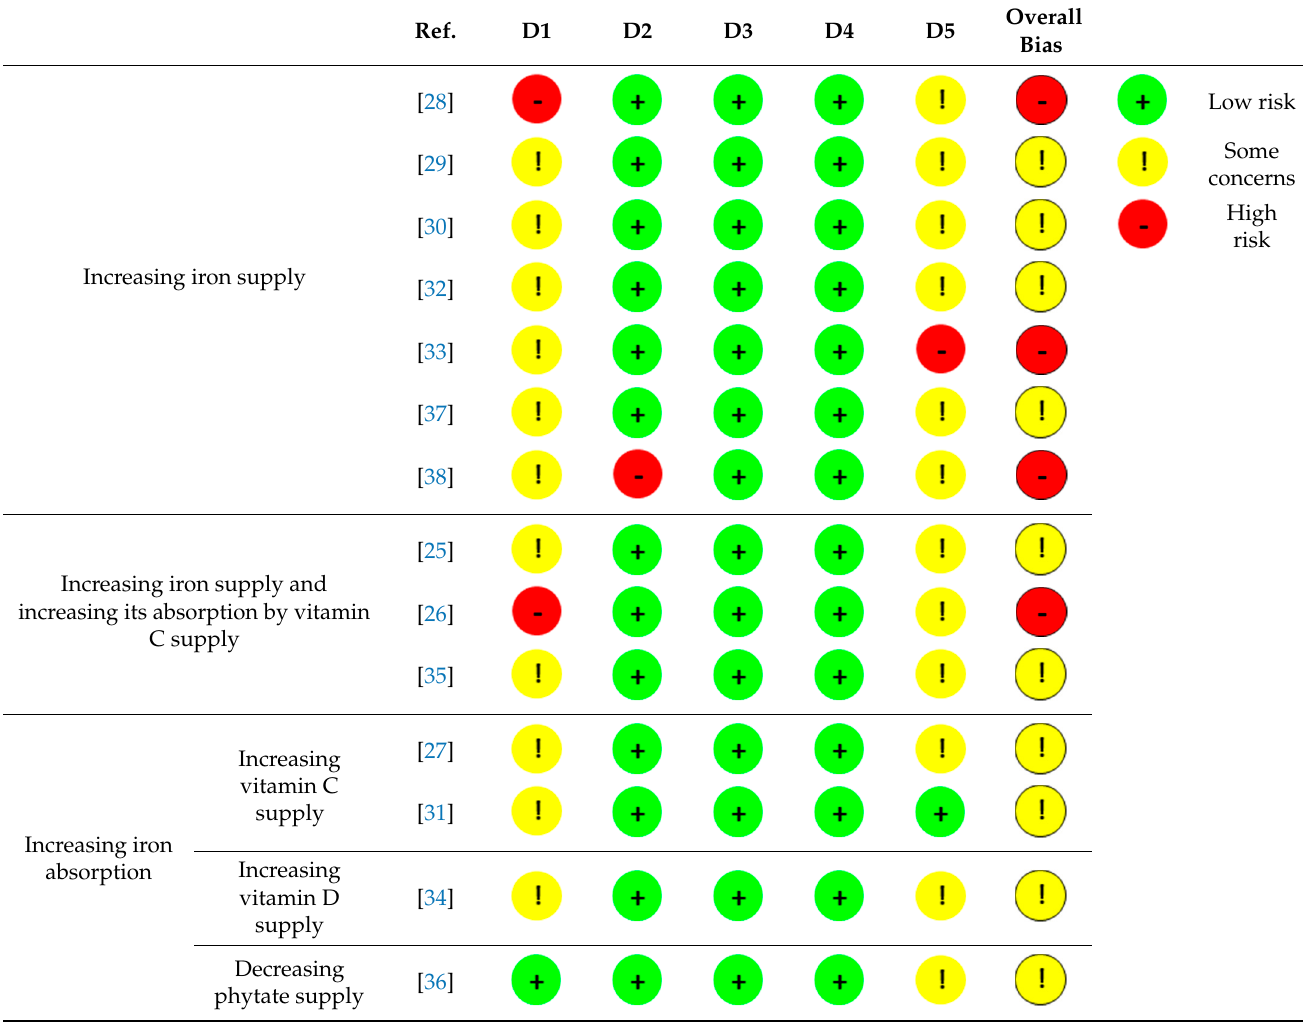
Table 7. The assessment of the risk of bias for the randomized controlled trials included in the sys- tematic review, conducted while using the revised Cochrane risk-of-bias tool for randomized trials. Assessed domains: D1—risk of bias arising from the randomization process; D2—risk of bias due to deviations from the intended interventions; D3—risk of bias due to missing outcome data; D4— risk of bias in measurement of the outcome; D5—risk of bias in selection of the reported result.